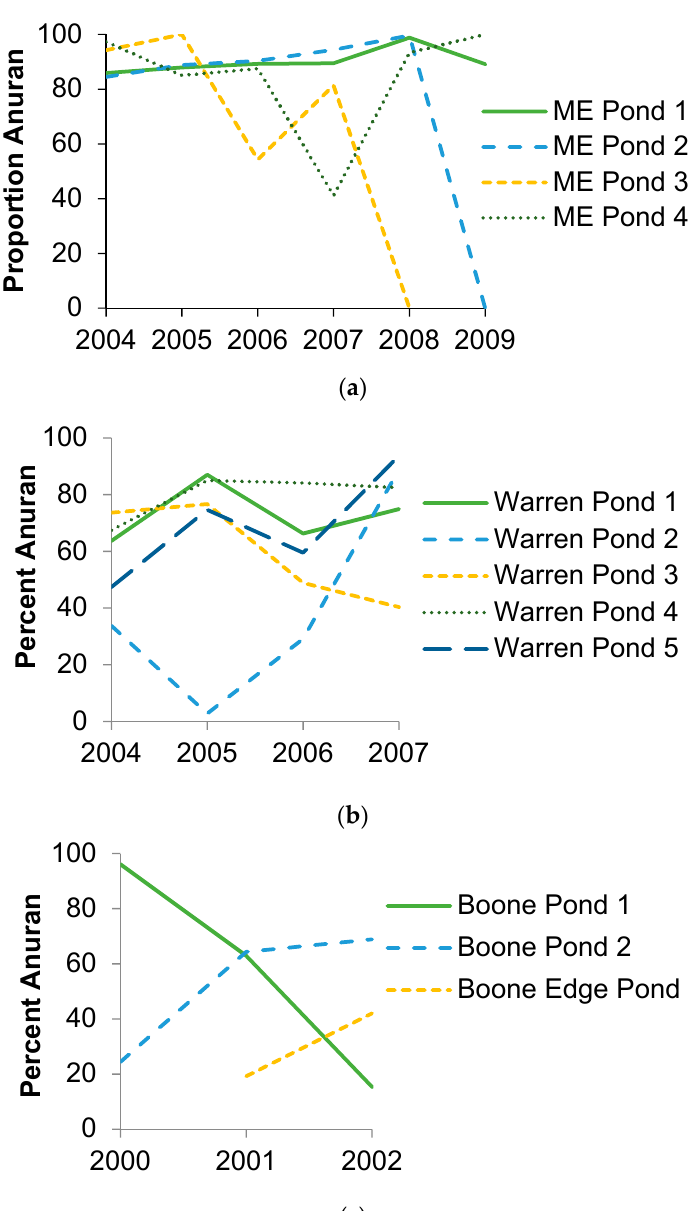
Figure 3. Percent of amphibian biomass export coming from anurans for ( a ) four ponds in Penobscot County, Maine (ME) over six years, ( b ) five ponds in Warren County, Missouri (DBCA) over four years, and ( c ) three ponds in Boone County, Missouri over two to three years (ponds 1 and 2: Baskett Wildlife Area, edge pond: Mark Twain National Forest).